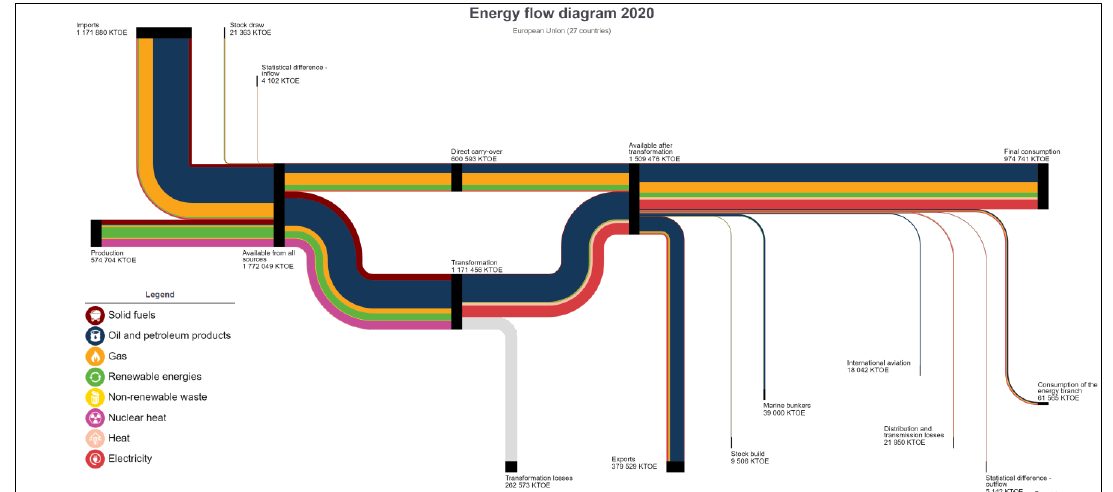
Figure 5. European Union energy dependency rate by source [44].